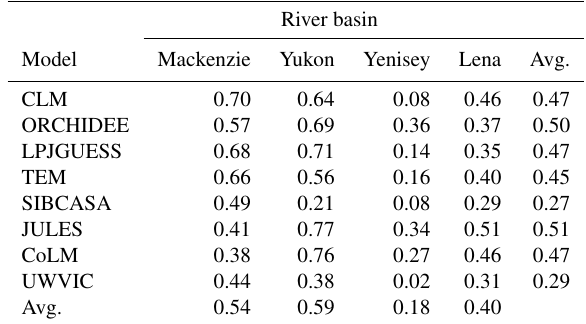
Table 3. Correlation coefficients between simulated annual total runoff and gauge mean annual discharge 1970 to 1999. SIBCASA correlations are for surface